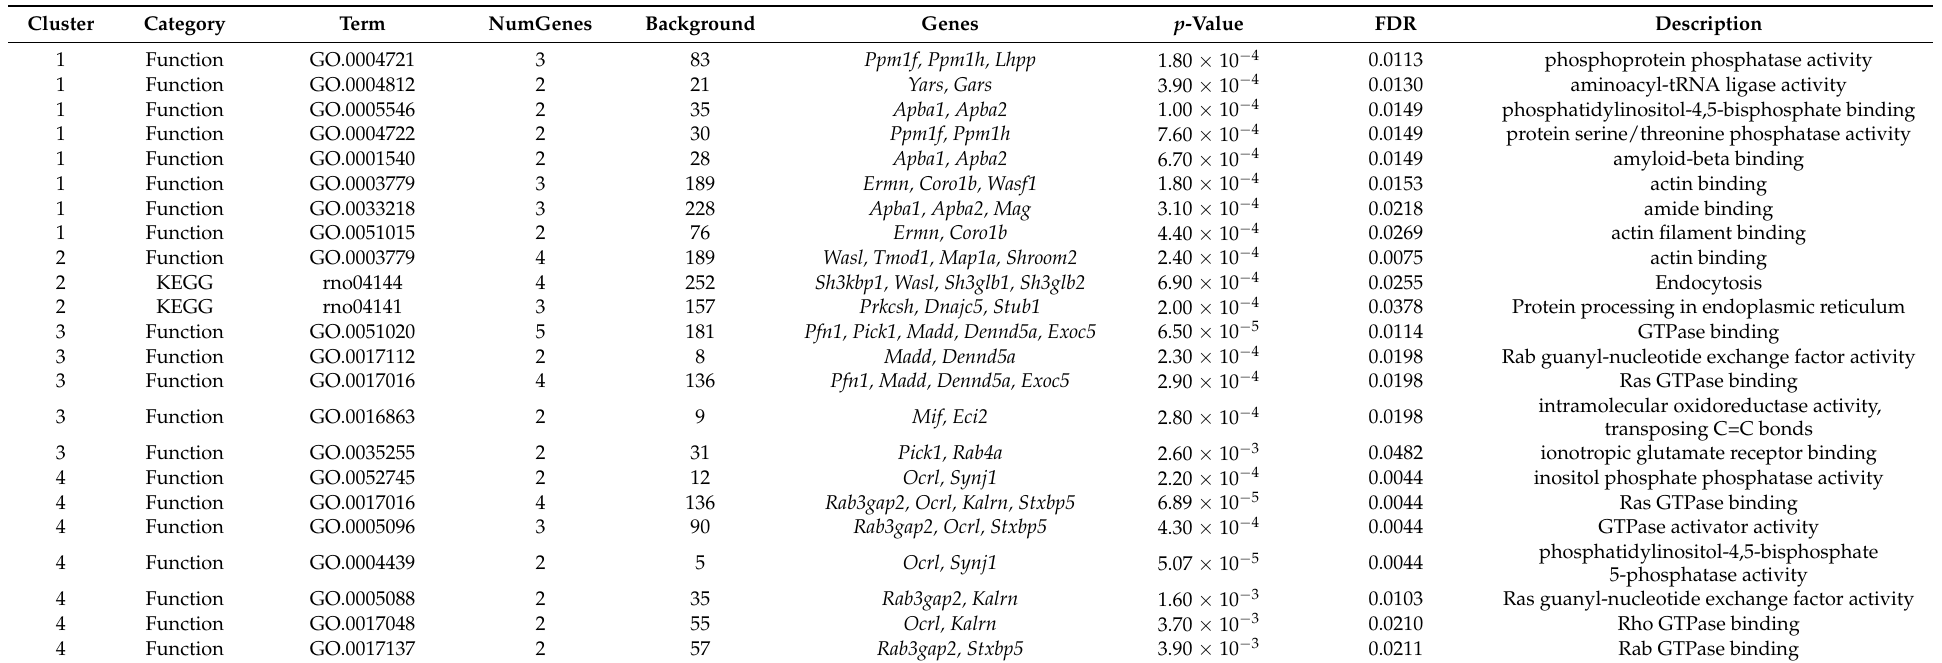
Table 1. Enrichments for the groups of proteins as they appear in the hierarchical cluster at Figure